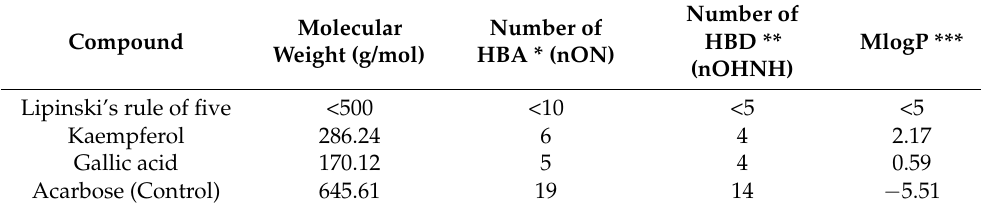
Table 3. Results of compounds examined for drug-likeness properties.